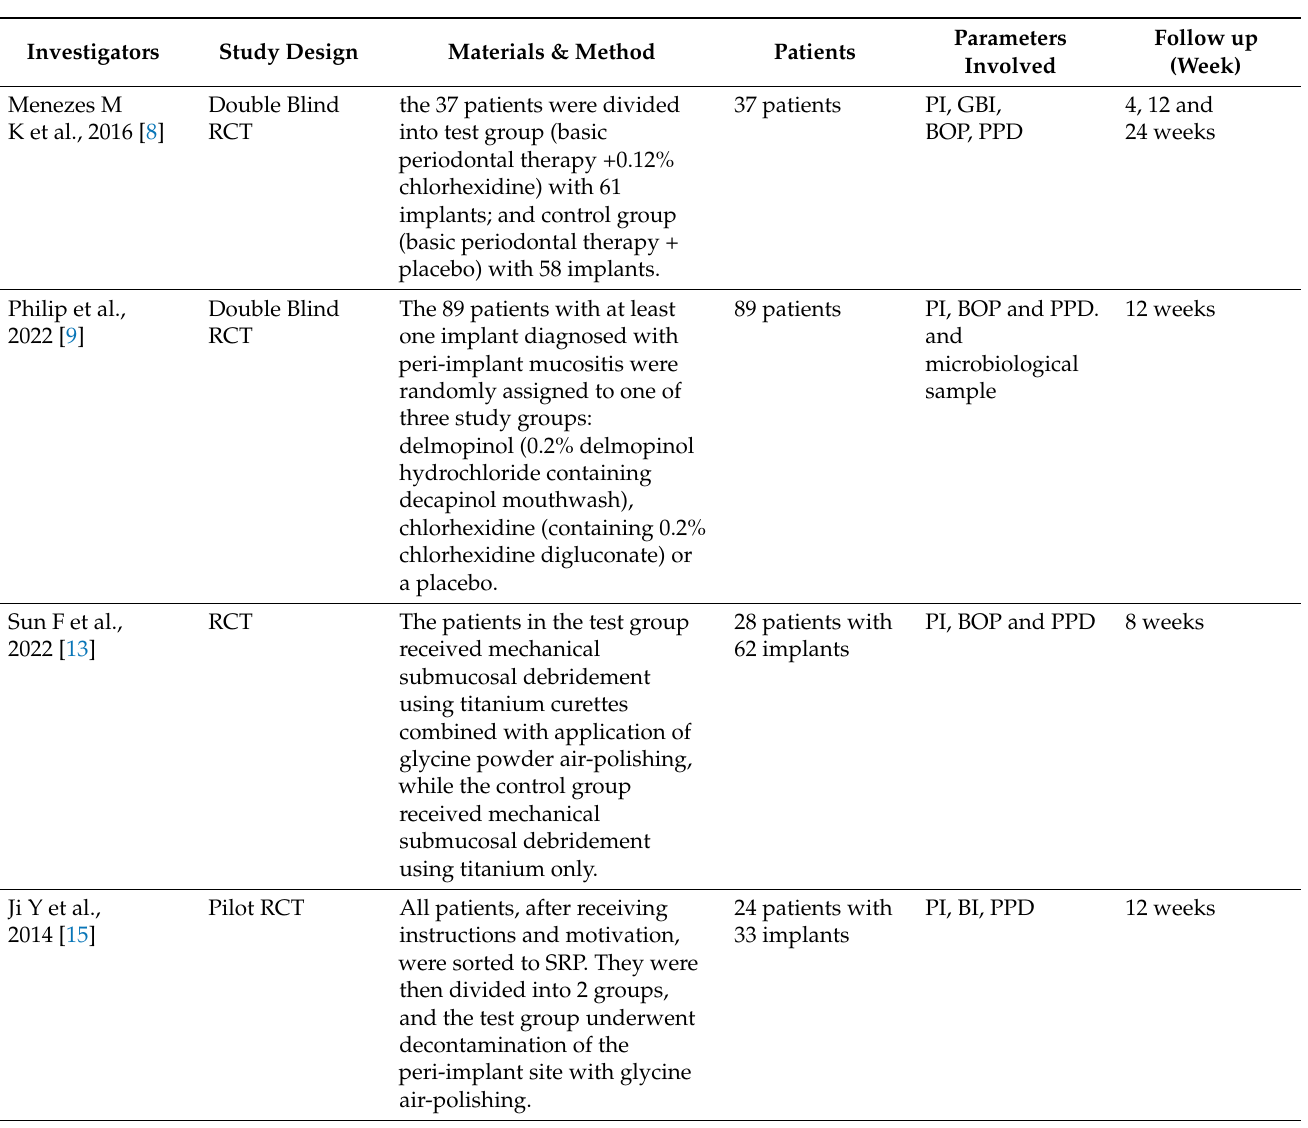
Table 5. Summary of RCT’s